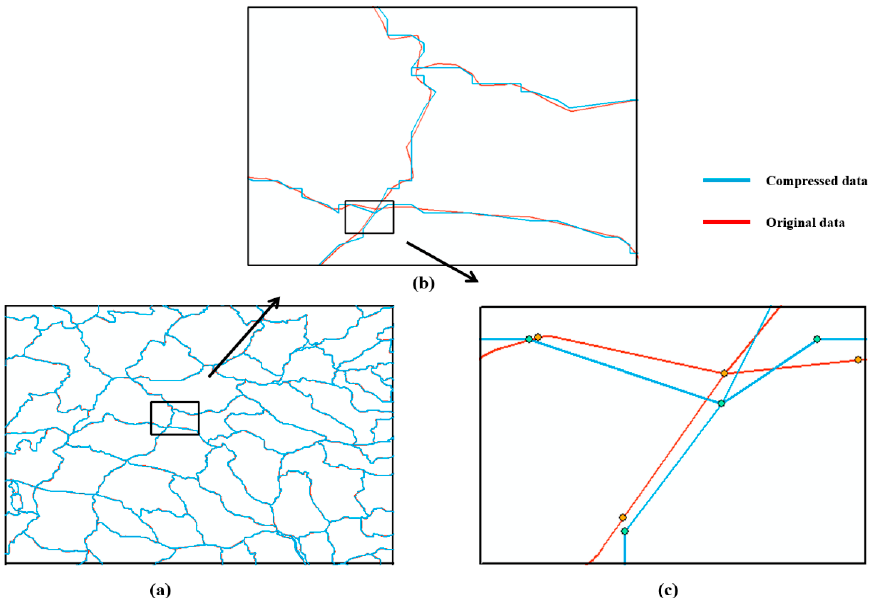
Figure 7. Overlaid result of di ff erent scale maps when n = 10. ( a ) is at the display scale of 1:1,000,000; ( b ) is at the display scale of 1:100,000; ( c ) is at the display scale of 1:25,000. ( b ) is at the display scale of 1:100,000; ( c ) is at the display scale of